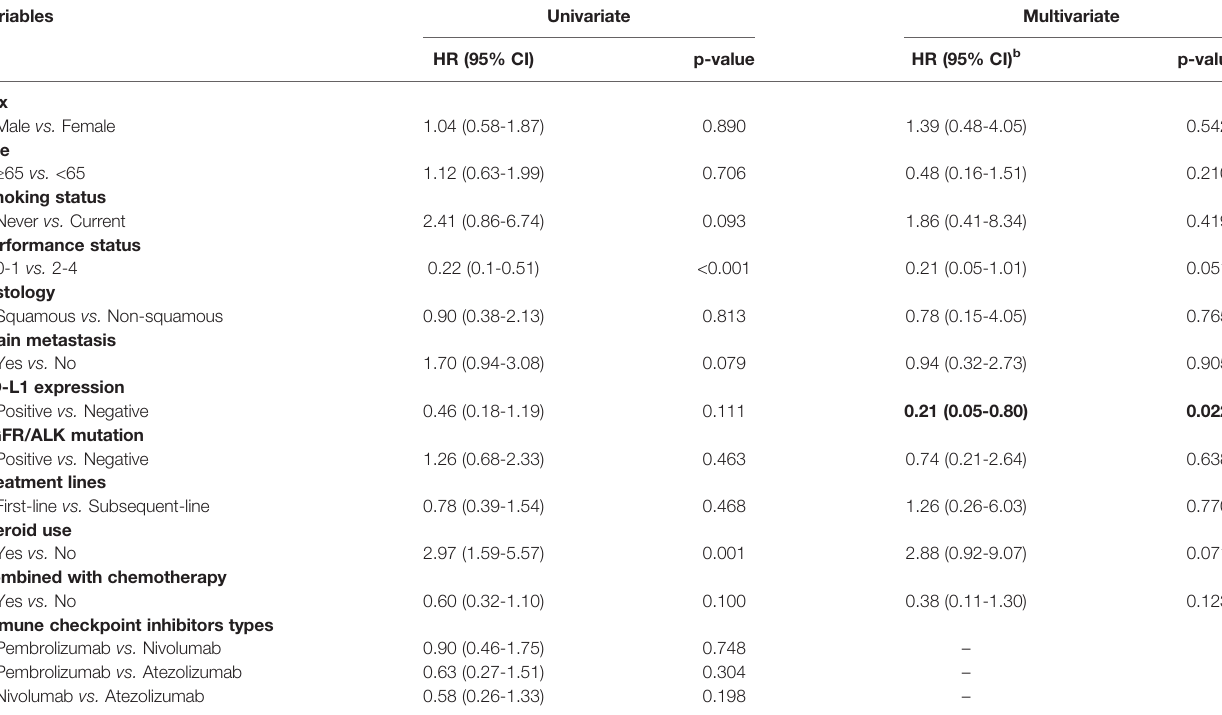
TABLE 2 | ICIs drugs use and its association with overall mortality by different covariates a . Variables Univariate